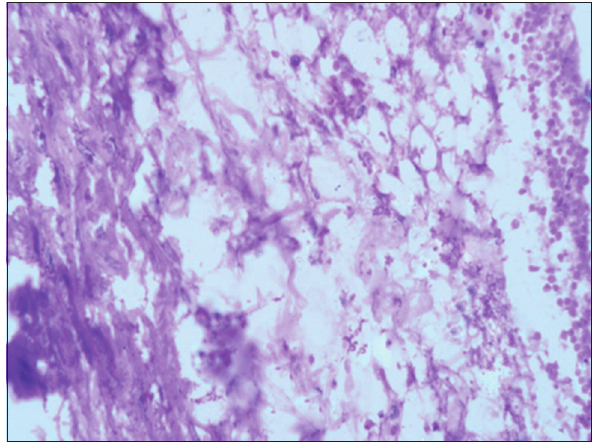
Figure-6: Aorta Group II section showing endothelial degeneration with subendothelial lipid-laden macrophages (foam cells) accumulation (H and E, 400×).